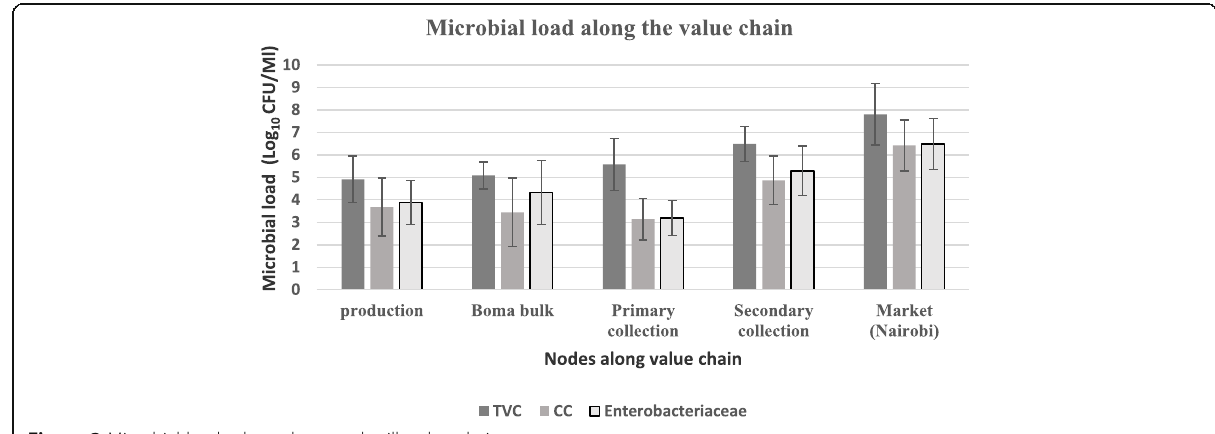
Figure 3 Microbial loads along the camel milk value